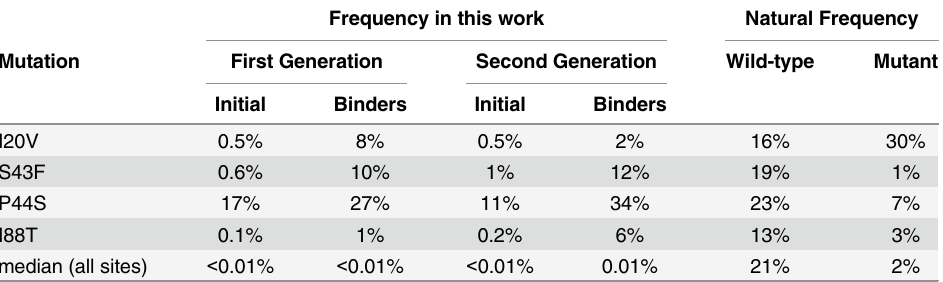
Table 4. Enrichment of framework mutations. Full length fibronectin sequences from first and second generation na ï ve and binder populations were analyzed. Four framework positions demonstrated enrichment for non-wild type residues. Prevalence of these amino acids in natural homologs is shown in the two right most columns. Bottom row indicates median values of wild-type and any single mutant across all sites.